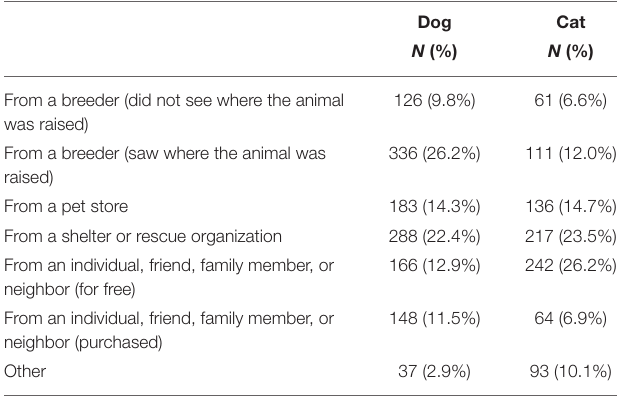
TABLE 3 | Sources of the 1,284 dogs and 924 cats acquired during the pandemic.